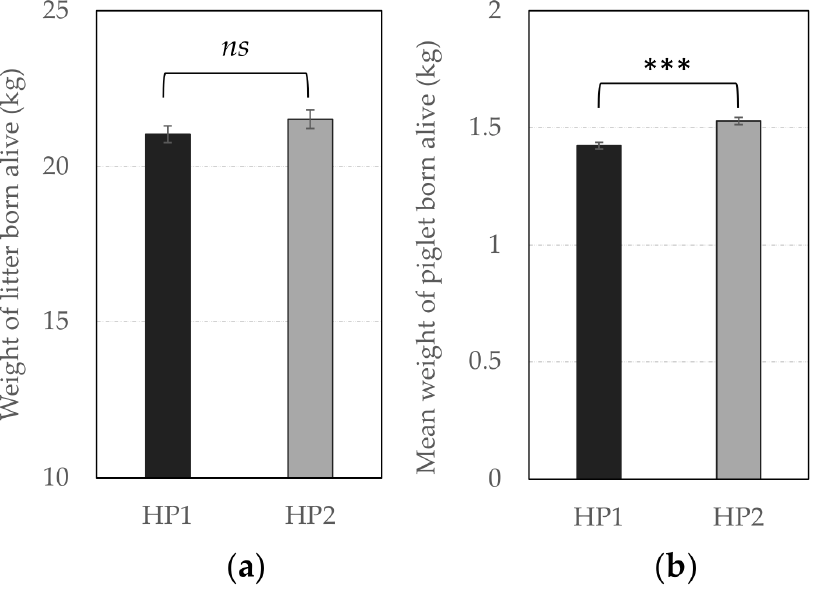
Figure 5. Average weight (± SEM) of ( a ) litter and, ( b ) piglets born alive (in kg) according to genetic line. *** Means differ significantly (*** p < 0.001) between genetic lines; ns —not significant.